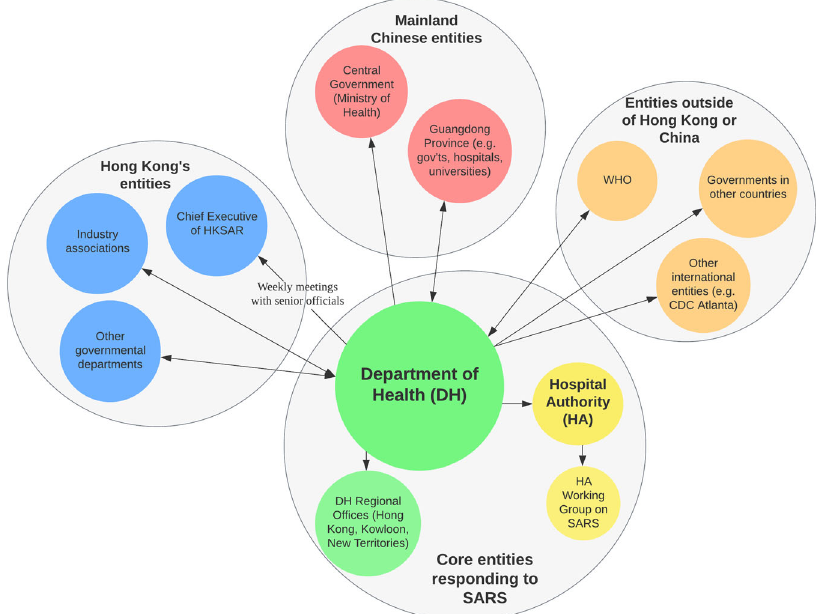
Fig. 2 The stakeholders under HA ’ s Working Group on SARS. The HA ’ s Working Group on SARS initially included only a small number of clinical experts, but expanded soon after to include many more members from other relevant disciplines, such as community medicine and infectious disease control.